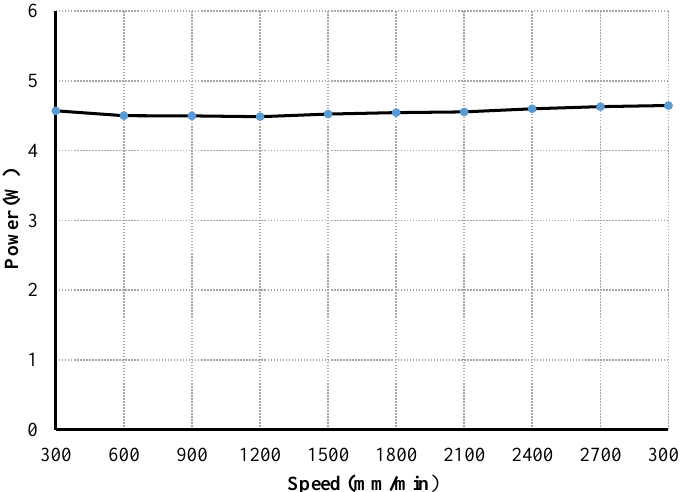
Figure 7. Power following the moving speed.